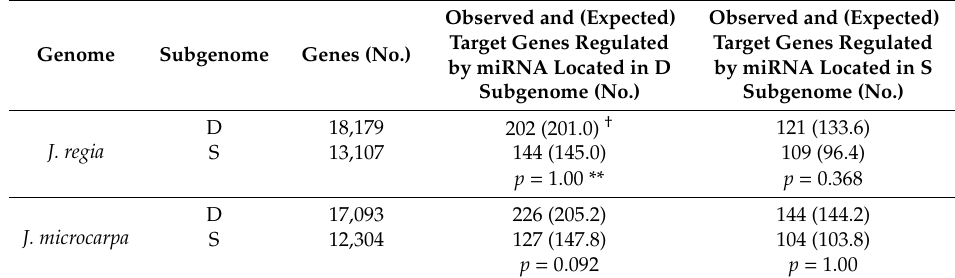
Figure 2. Chromosomal distribution of the pre-miRNAs in the J. regia ( A ) and J. microcarpa ( B ) genomes. The colors of the miRNA accession names indicate di ff erent miRNA families. Table 2. Observed numbers of target genes by miRNAs located in the D and S subgenomes in J. regia and J. microcarpa genomes and expected numbers based on the total numbers of genes in the D and S